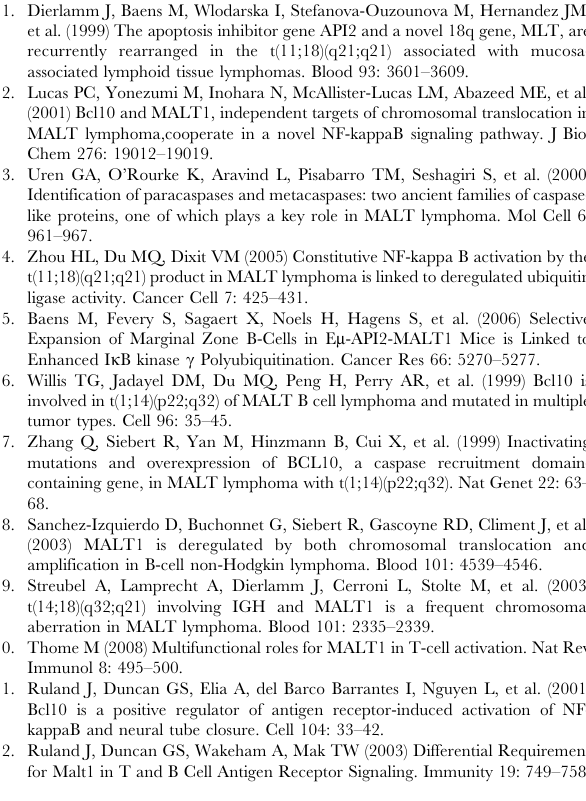
Table S2 Differentially expressed genes at 3 and 18 hrs of stimulation with PMA/Ionomycin in J D M-CA, J D M-RA and RACA vs MALT1 expressing cells with more than 2 fold change and FDR q , 0,001. Table S3 qRT-PCR validation of differentially ex- pressed genes between MALT1 and J D M-CA, J D M-RA and RACA respectively at 3 and 18 hrs of stimulation with PMA/Ionomycin. Table S4 Gene set enrichment analysis of NF- k B target genes (Boston) in the pre-ranked sets of ‘‘differentially expressed genes’’ for J D M-CA, J D M-RA and RACA at 3 and 18 hrs of stimulation with P/I. Table S5 Ingenuity Pathway analysis of differential expression of J D M-CA, J D M-RA and RACA